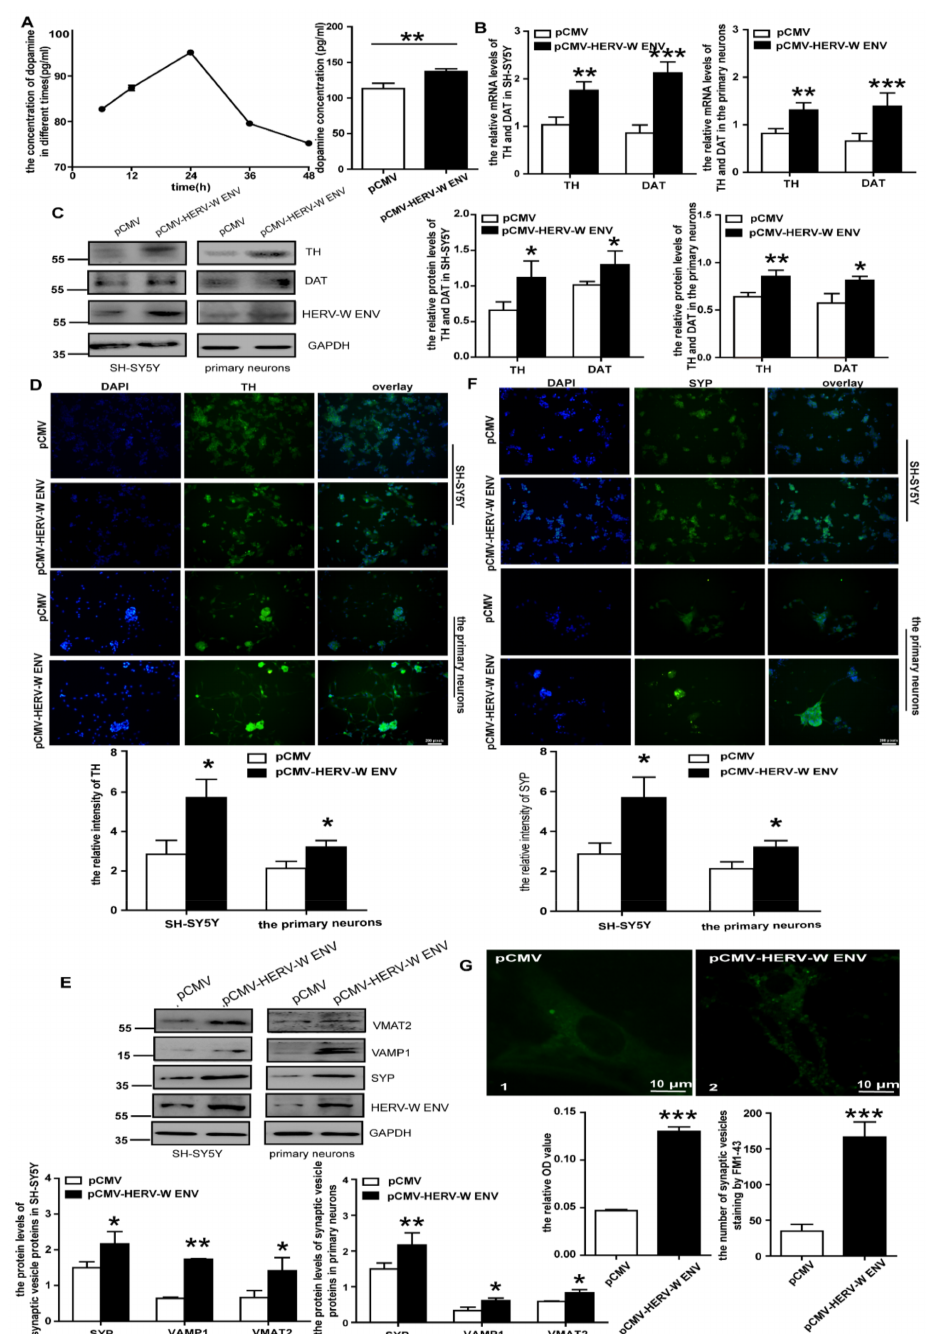
Figure 3. HERV-W ENV facilitates the synthesis and transport of DA: ( A ) DA concentration in the culture supernatants of SH-SY5Y cells reached the highest peak 24 h after transfection and the concentration in the HERV-W ENV overexpressed group was greater than the control. ( B ) The mRNA levels of TH and DAT in the HERV-W ENV overexpression group were higher than the control group in the DA neurons. ( C ) The protein level of TH and DAT in the HERV-W ENV overexpression group was higher than the control group in the DA neurons. ( D ) Cellular immunofluorescence assays of TH in the DA neurons. ( E ) Representative Western blots for the synaptic vesicle-related proteins and GAPDH in the DA neurons. ( F ) SYP expressed higher in the HERV-W ENV overexpression group by cellular immunofluorescence. ( G ) STED images of FM 1-43 in the primary neurons between the pCMV group (1) and pCMV-HERV-W ENV group (2). The OD value and number of SVs increased after HERV-W ENV overexpression. * p < 0.05, ** p < 0.01, *** p <